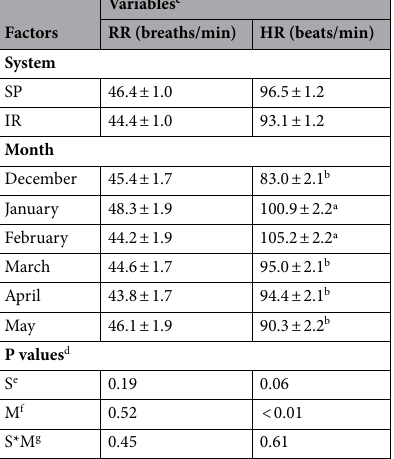
Table 1. Least square mean ± standard error of the physiological responses of heifers in silvopastoral (SP; n = 16) or intensive rotational grazing (IR; n = 16) systems. a,b Means followed by different lowercase letters on the same column are significant. c RR respiratory rate, HR heart rate, d P values < 0.05 were considered significant. e S system, f M month (experimental month), g S*M interaction between system and month.